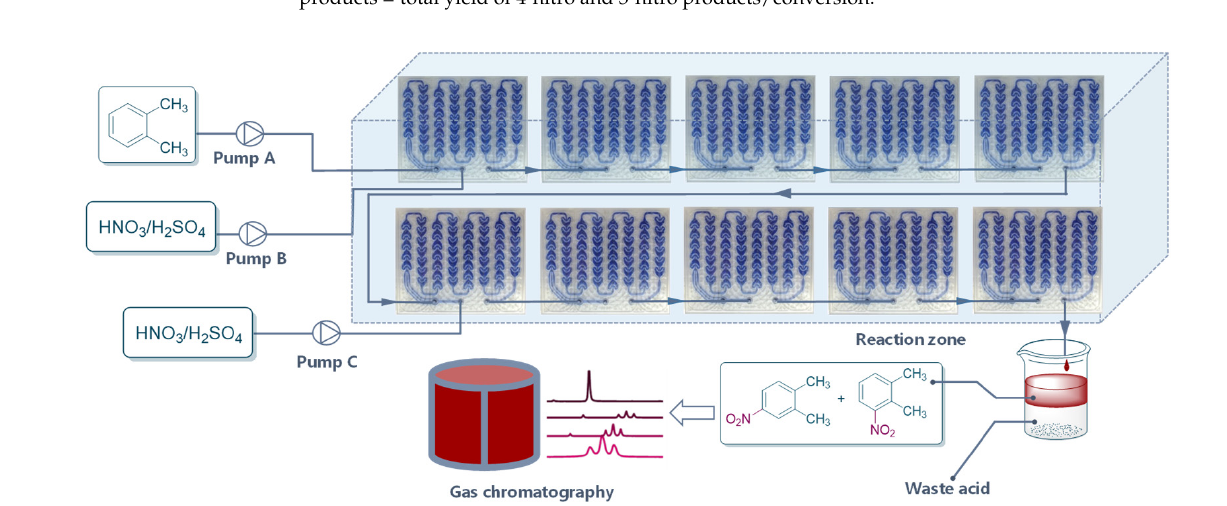
Table 1. Influence of residence time on the reaction a.